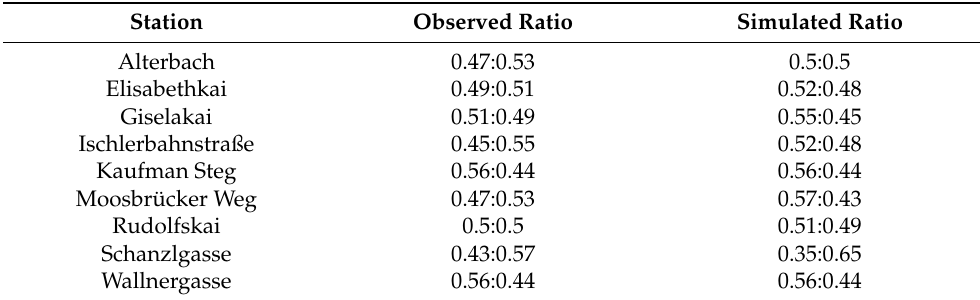
Table 5. The ratios of traversed cyclists at stations during the morning peak vs. afternoon peak.